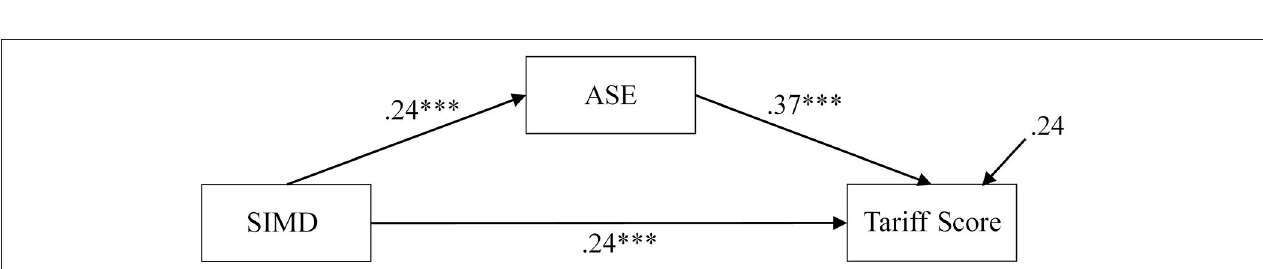
FIGURE 2 | Combined effects path model showing standardized estimates. *** p < 0.001.